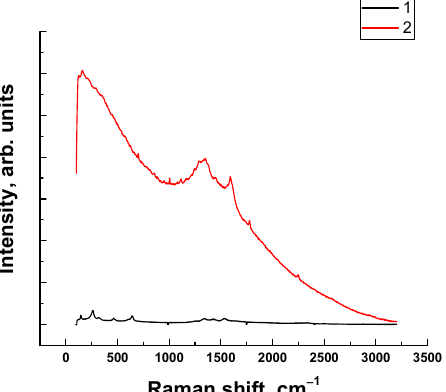
Figure 11. The Raman spectra outside (1) and inside the wear track (2) of the PEI/10CCF/1HNT nanocomposite. Linear tribological contact. P = 60 N, V = 0.3 m/s.